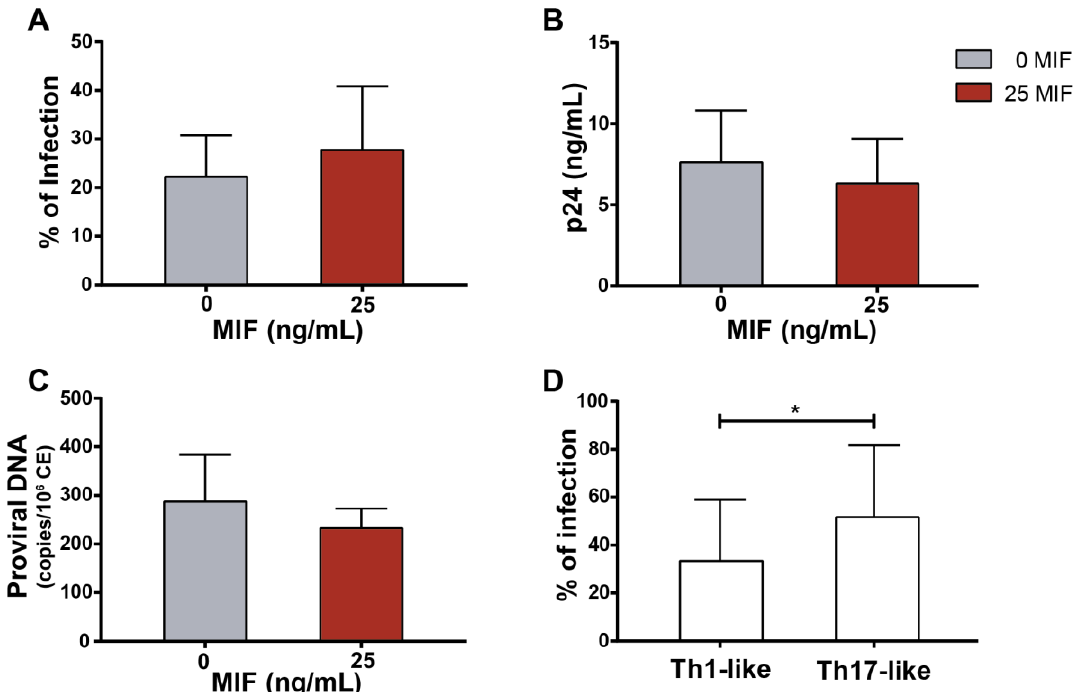
Figure 3. HIV infection on CD4TL and viral production on infected co-cultures. ( A ) Proportion of p24 + events within CD4TL bulk population. ( B ) p24 viral protein concentration in culture supernatants. ( C ) HIV DNA pro-viral DNA copies per million of cells within CD4TL bulk population. ( D ) Proportion of p24 + events within Th17-like and Th1-like CD4 T-cell populations. Data represent the mean ± SD of three independents experiments each one performed in triplicate. Data analysis was performed with Student ’s t -test (* p < 0.05).